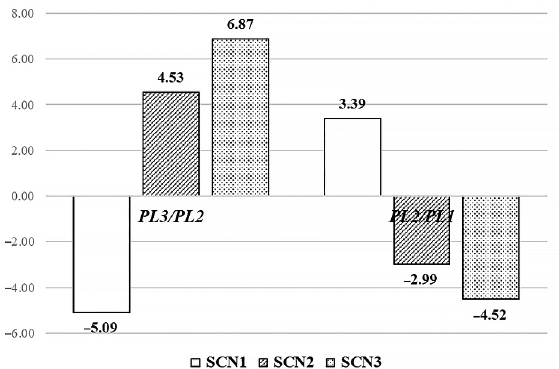
Figure 8. Changes of wage differentials among workers in 2030 (% relative to the